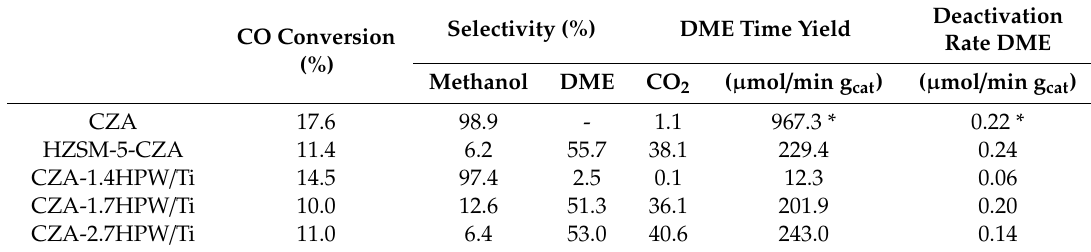
Table 4. Initial catalytic activity data (CO conversion, selectivity and DME time yield) and deactivation (decay in umol DME / min g cat ) in direct DME synthesis from syngas over reduced CZA-xHPW / Ti hybrid catalysts (Data for methanol synthesis on CZA and DME synthesis on CZA-HZSM-5 catalysts were included as references). Figure 11. DRIFT spectra of CZA-xHPW/Ti hybrid catalysts: CZA-1.4HPW/Ti (a), CZA-1.7HPW/Ti (b) and CZA-2.7HPW/Ti (c).